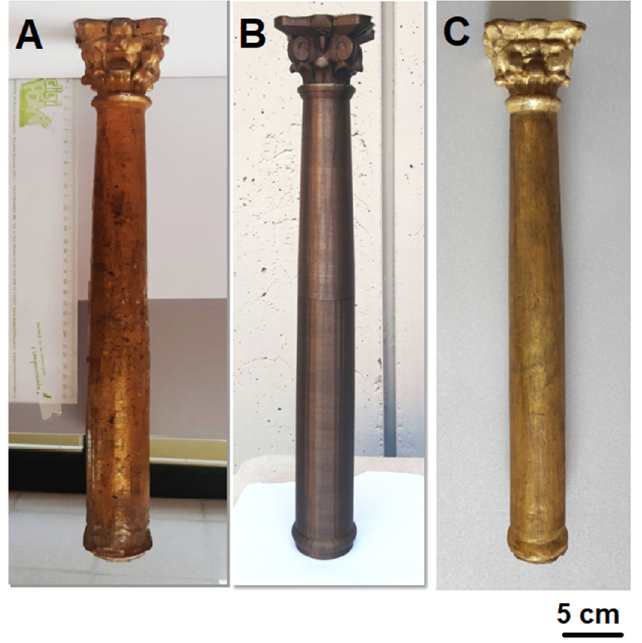
Figure 8. Original column ( A ); PETG printed column replica ( B ); and PETG column after restora- tion ( C ).